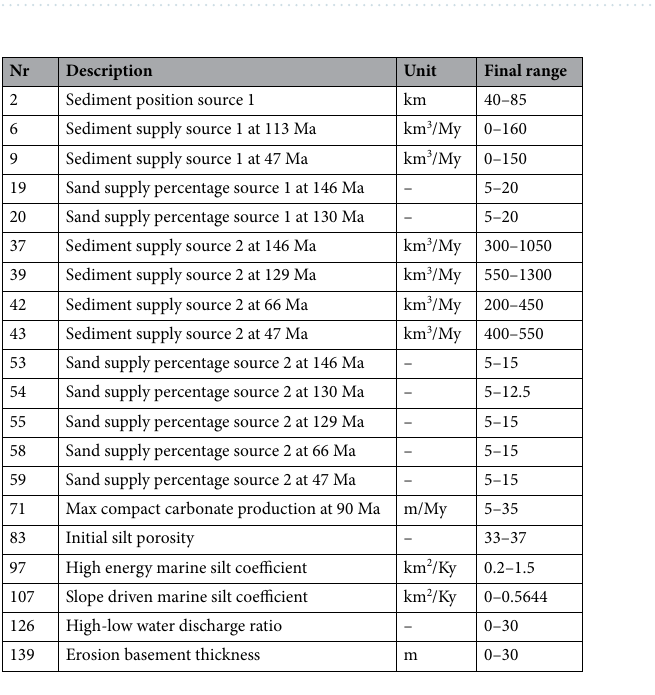
Table 1. Parameters used to build the surrogate model together with their units and final